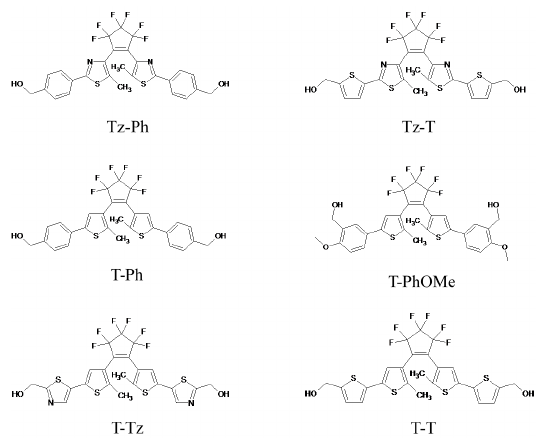
Figure 1. Chemical structure of the photochromic monomers.